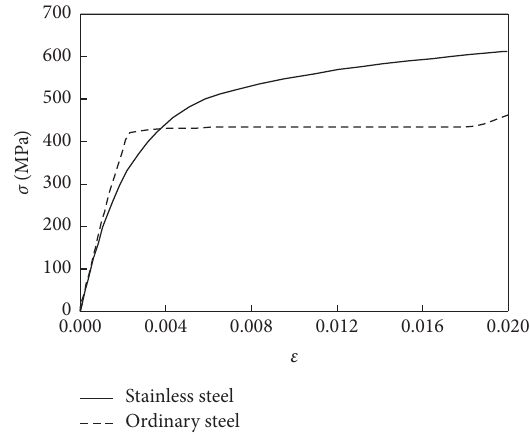
Figure 1: Stress-strain curves of ordinary steel and stainless steel.